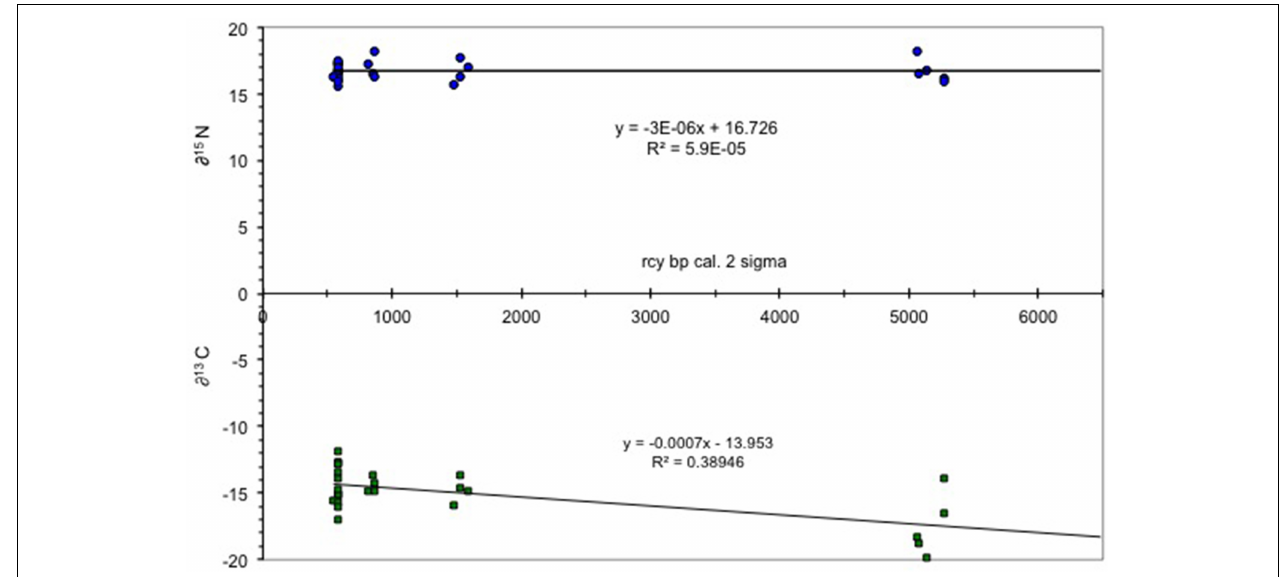
FIGURE 2 | δ 13 C/ δ 15 N values for Pacific cod. Figure shows δ values plotted vs. time with little to no change in δ 15 N and a trend to heavier δ 13 C values from the early Holocene (7000rcy BP) to the more recent (ca 0.578rcy BP). Total number of samples = 28.